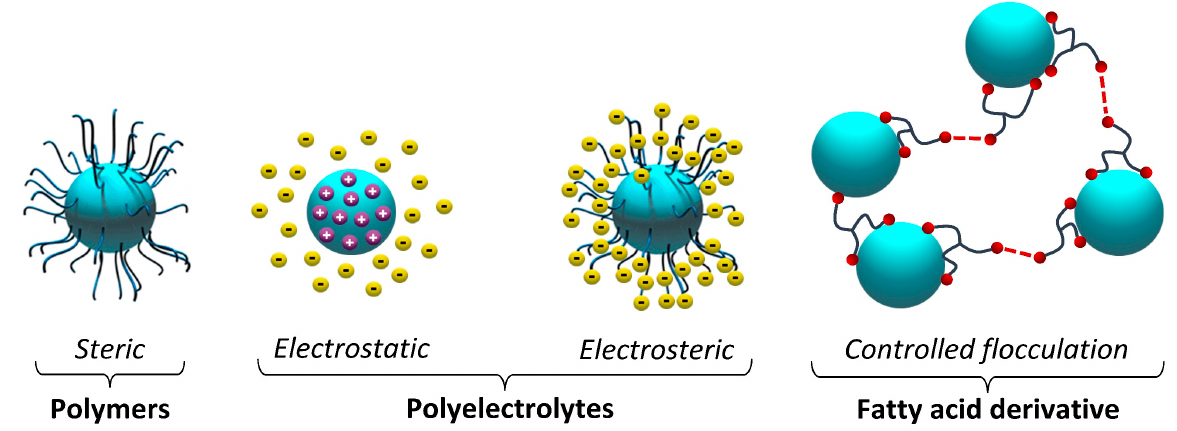
Figure 1. Stabilization mechanisms according to the type of dispersant.